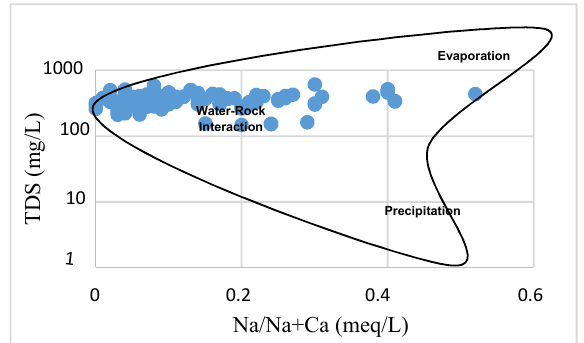
Fig. 7. The Gibbs diagram of the study